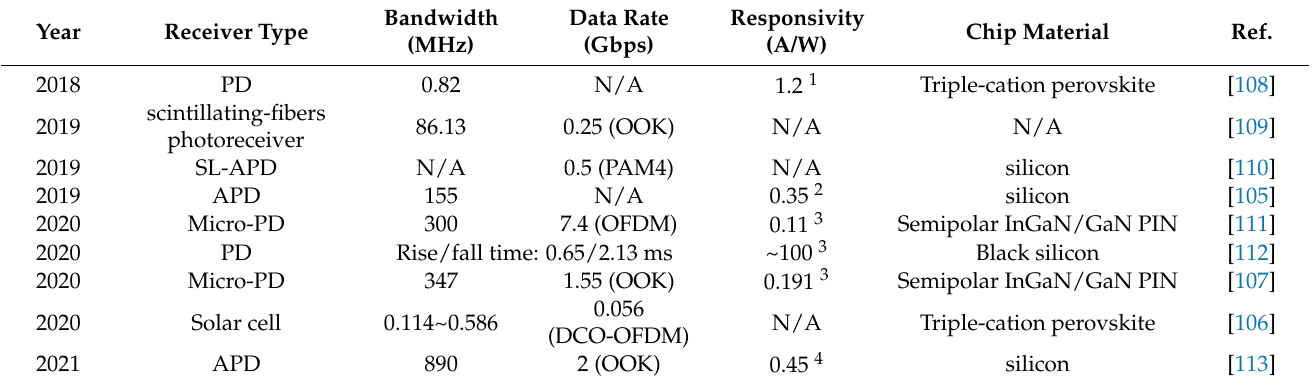
Table 3. Recently proposed receiver for VLC